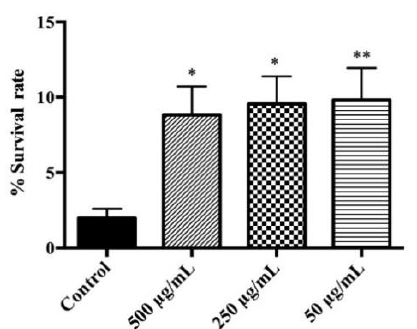
Figure 2. Effect of Rosmarinus officinalis flower extract on the response to a lethal oxidative stress induced by juglone (150 μ M) on C. elegans. Control ( n = 383), 500 ( n = 399), 250 ( n = 327) and 50 ( n = 391) μ g/mL groups, where n = number of individuals assayed. Differences compared to the control group were considered significant at p ≤ 0.05 (*) and p ≤ 0.01(**).